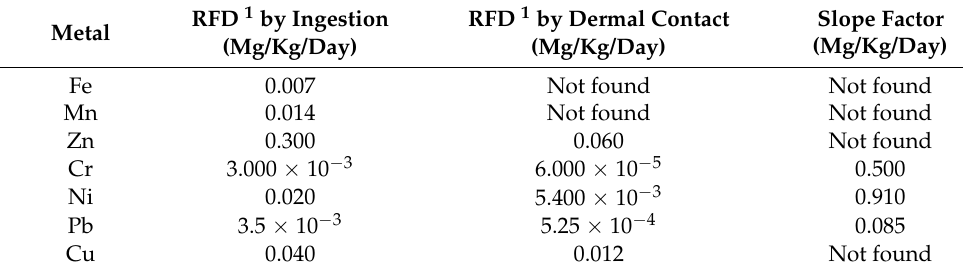
Table 2. RFD and SF values for heavy metals